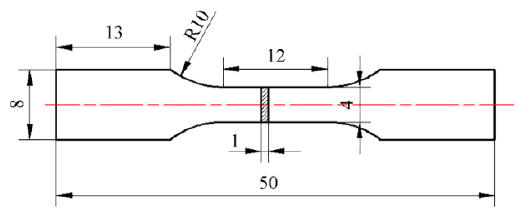
Figure 1. The dimensions of the specimens for tensile testing.